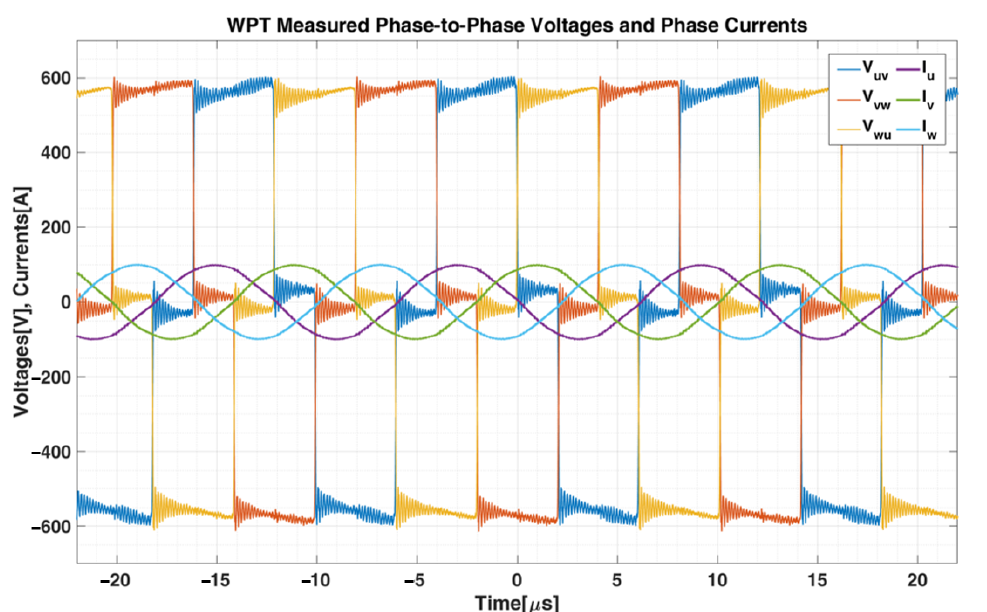
Figure 12. Measured phase-to-phase voltages ( V uv , V vw , V wu ) and phase currents ( I u , I v , I w ) on the primary side of WPT unit and at output DC